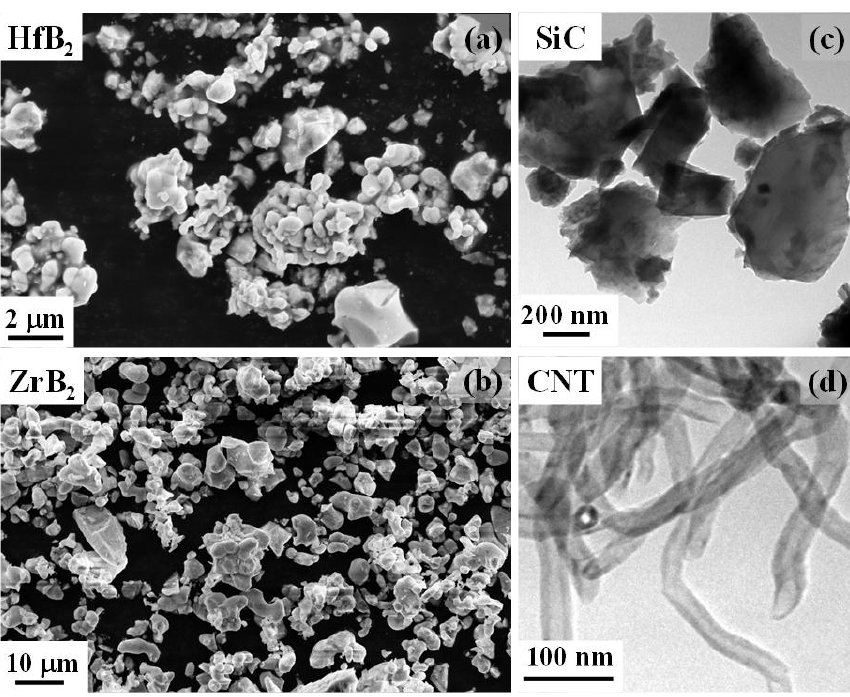
Figure 1. SEM micrographs of the starting powder ( a ) HfB 2 , and ( b ) ZrB 2 . TEM micrographs of the reinforcements: ( c ) SiC and ( d ) CNT.